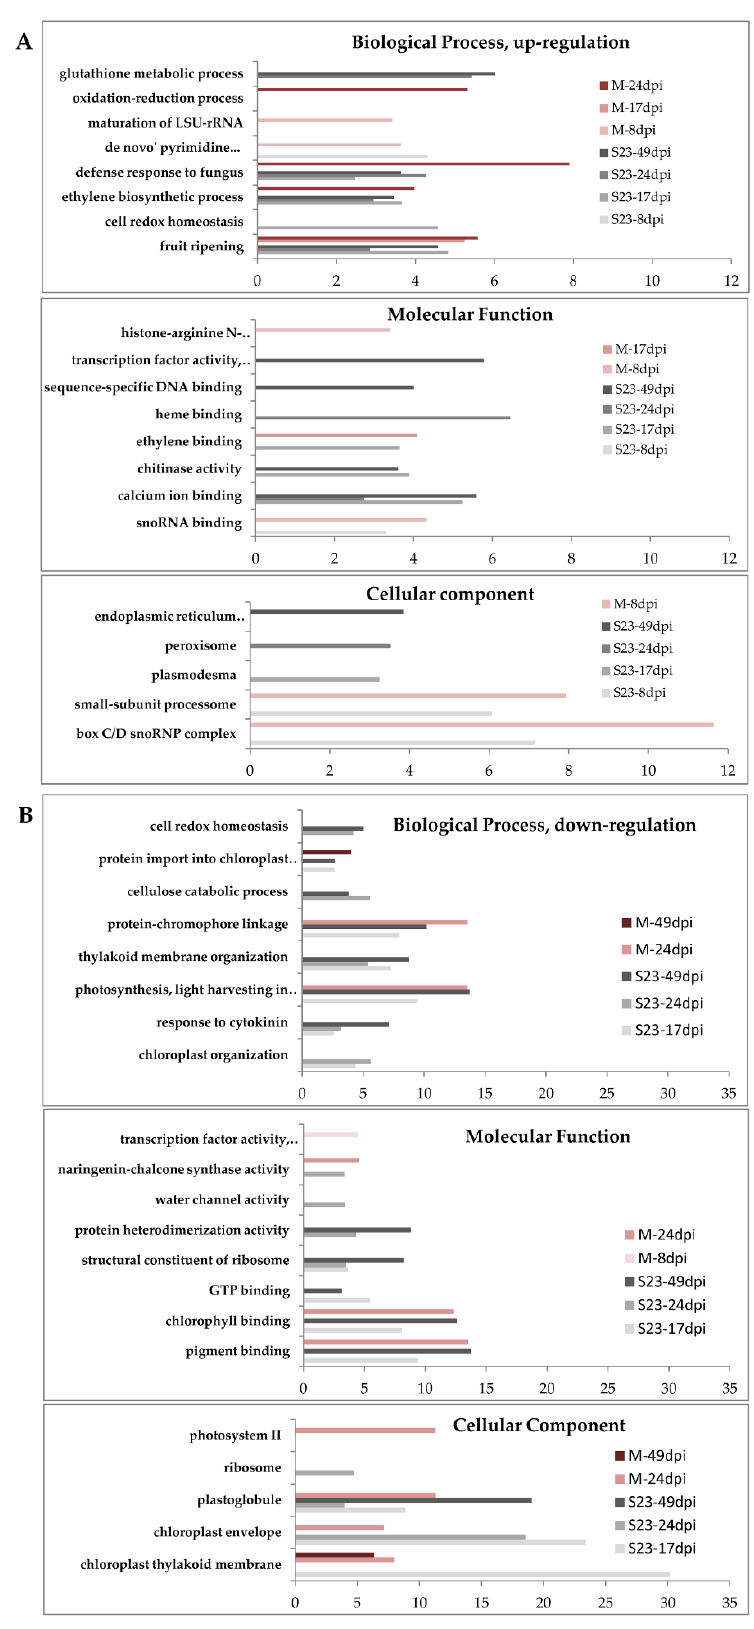
Figure 4. GO enrichment analysis. ( A , B ) up- and down-regulated genes, respectively. Only selected GO terms for the S23 and M variants at the indicated times after inoculation are presented. Categories are indicated on the Y-axis, log 10 (1/p) is on the X-axis; enrichment p value < 0.005 was used as a cutoff.